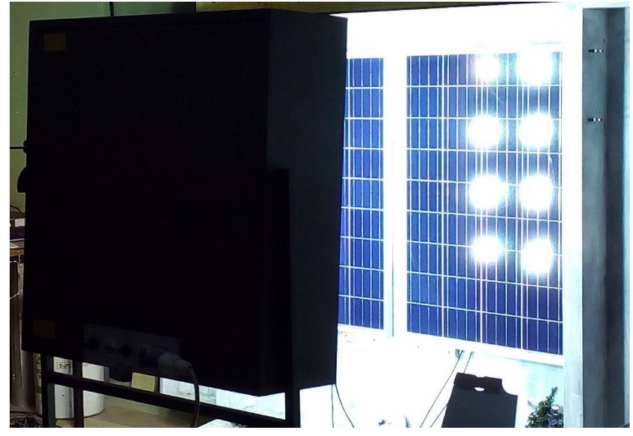
Figure 5. Panels tested with solar simulator at laboratory condition.